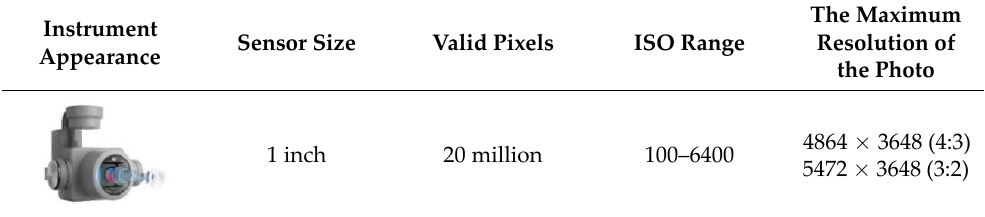
Table 2. Optical sensor parameters.